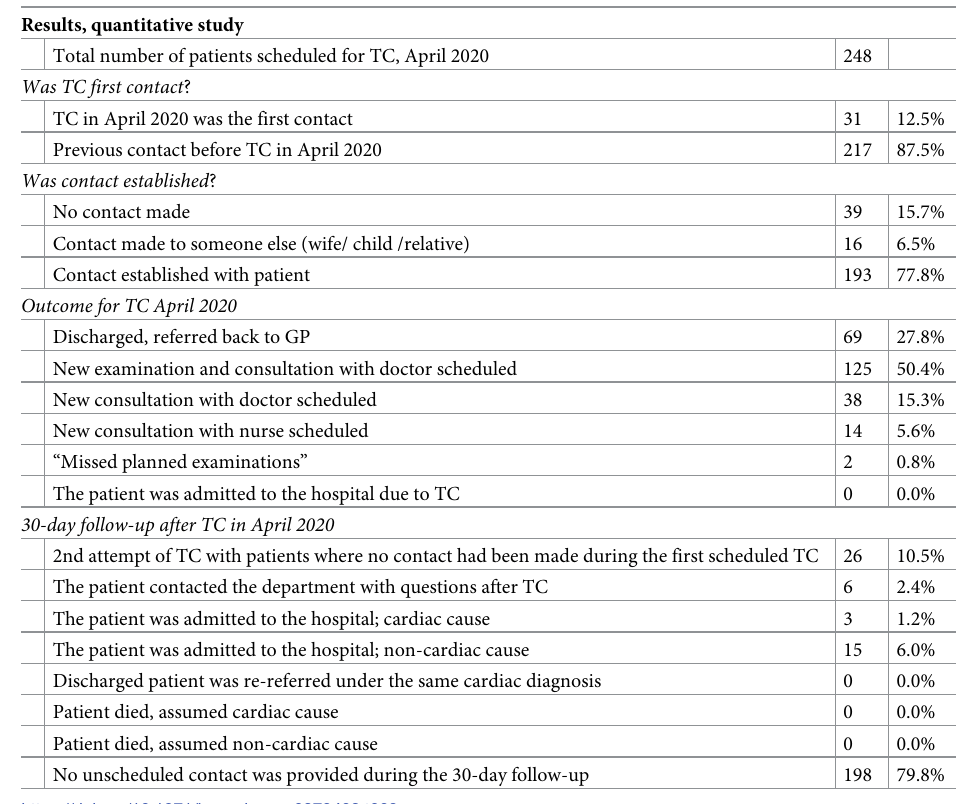
Table 3. Results, quantitative study.